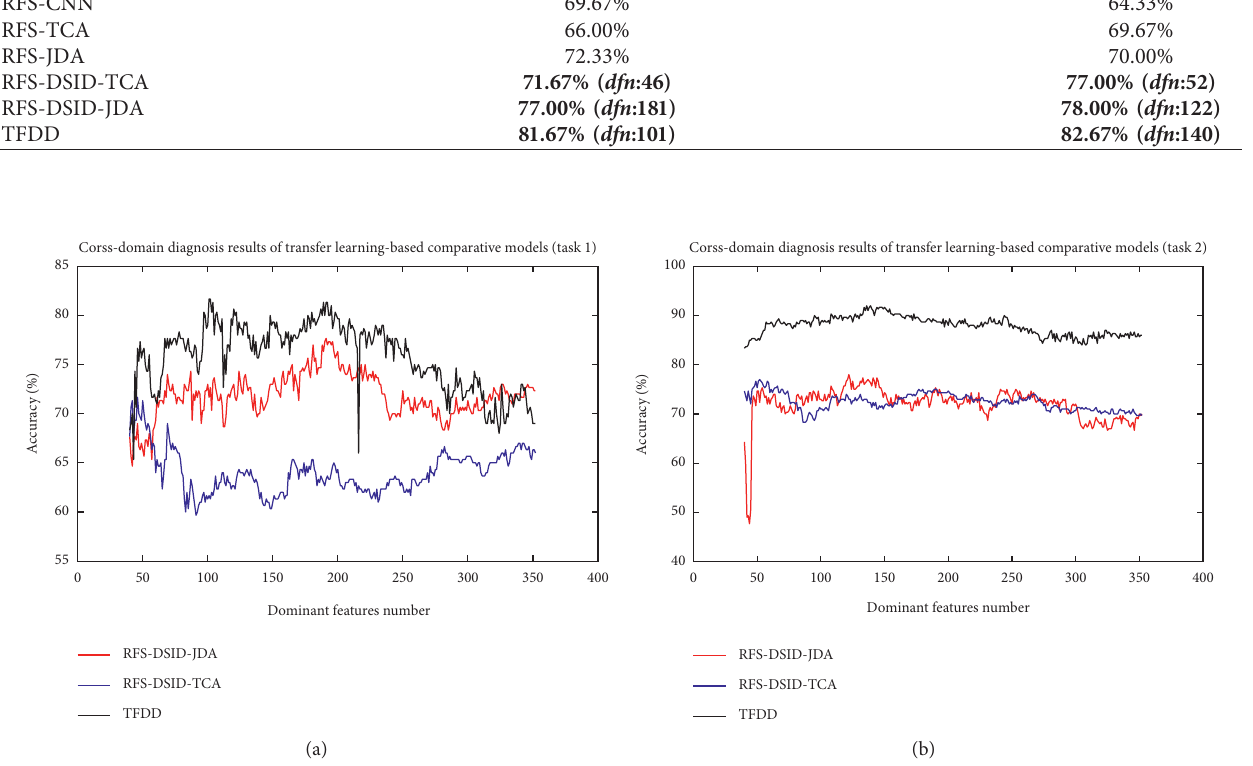
Figure 15: The diagram of cross-domain fault diagnosis results of transfer learning-based comparative